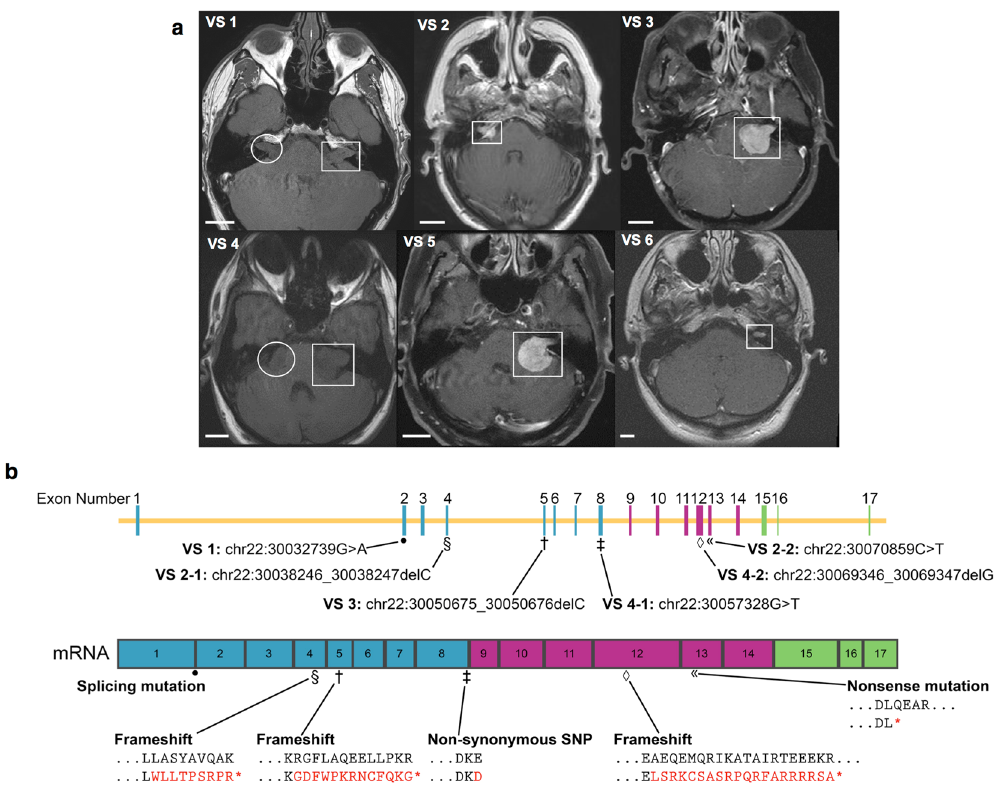
Figure 3. Tumor size and NF2 mutation type show no relationship with response to mifepristone. ( a ) MRI scans of six VS patients whose primary tumor cells were treated with mifepristone after surgical resection (for scans of four additional, non-sequenced tumors, see Supplementary Fig. S4). White rectangles, VSs; white circles, second (smaller) VSs in NF2 patients, who presented with bilateral VSs. Scale bars, 20 mm. Scans for VS 1 and VS 4 were conducted without the use of contrast agent due to patient intolerance. ( b ) Schematic of NF2 gene (above) and resulting mRNA (below), describing mutation locus, mutation type, and resulting amino acid change for each tumor in ( a ). Tumors 2 and 4 each contained two mutations in the NF2 gene, while for tumors 5 and 6, NF2 mutations were not